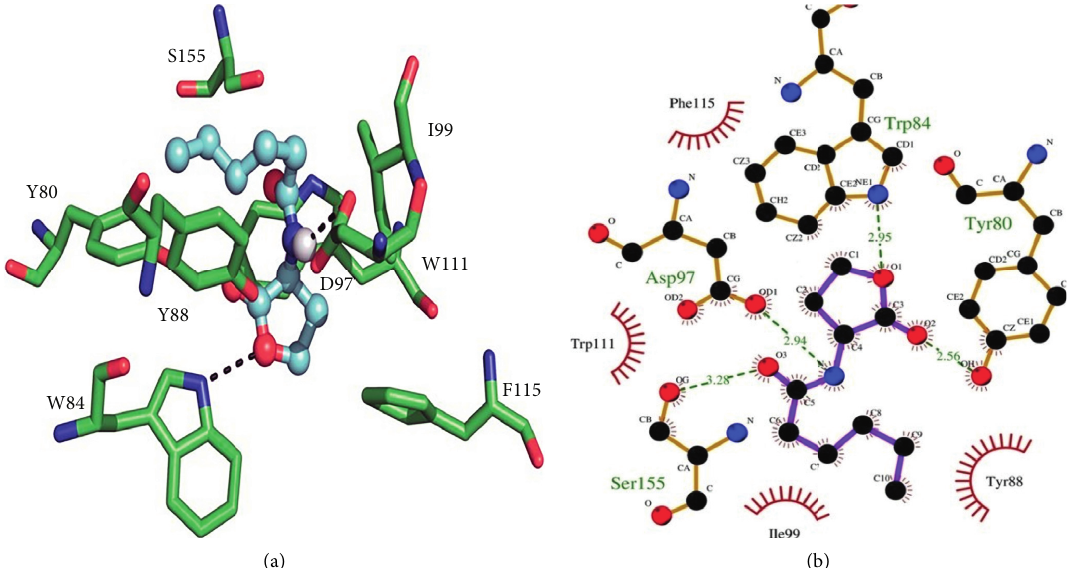
Figure 5: Schematic 2D diagram showing the interactions between N -hexanoyl homoserine lactone and CviR. The hydrophobic residues of the protein receptor that make contact with the ligand are represented by semicircles and radiant